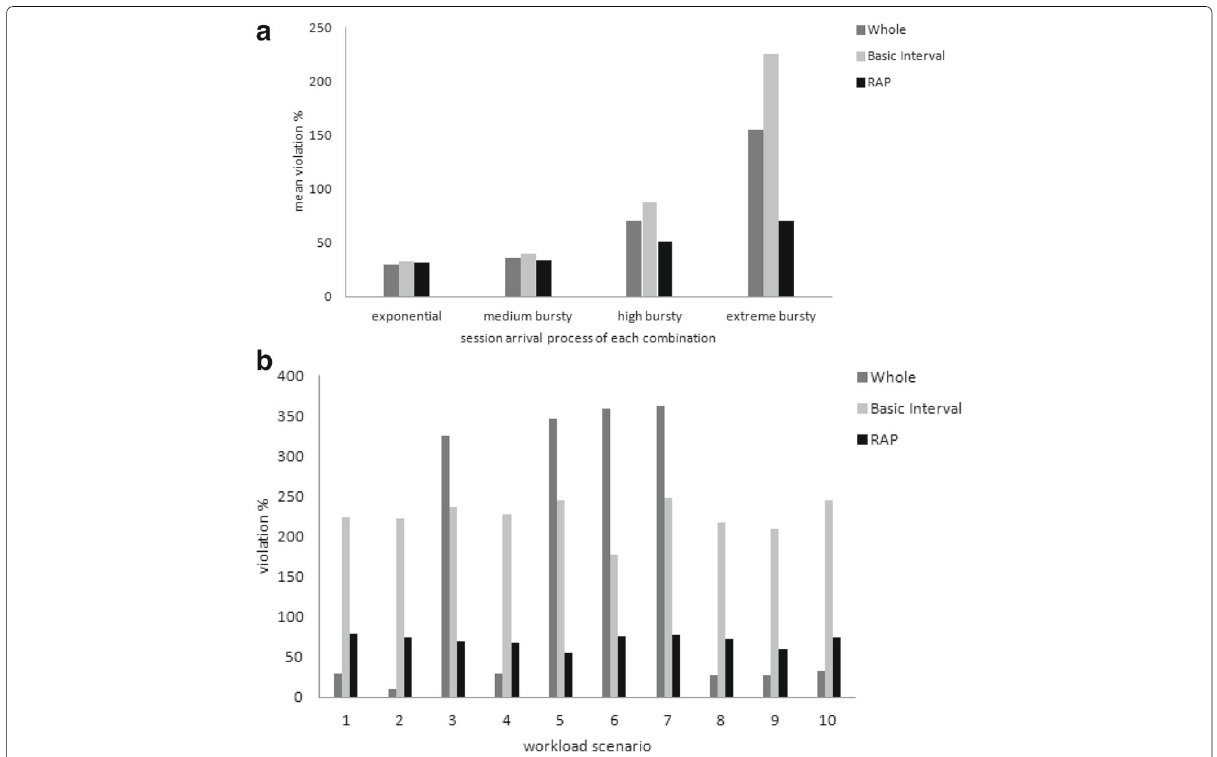
Fig. 10 SLO violation percentages. a Mean violation percentage. b Violation percentages of the extreme bursty